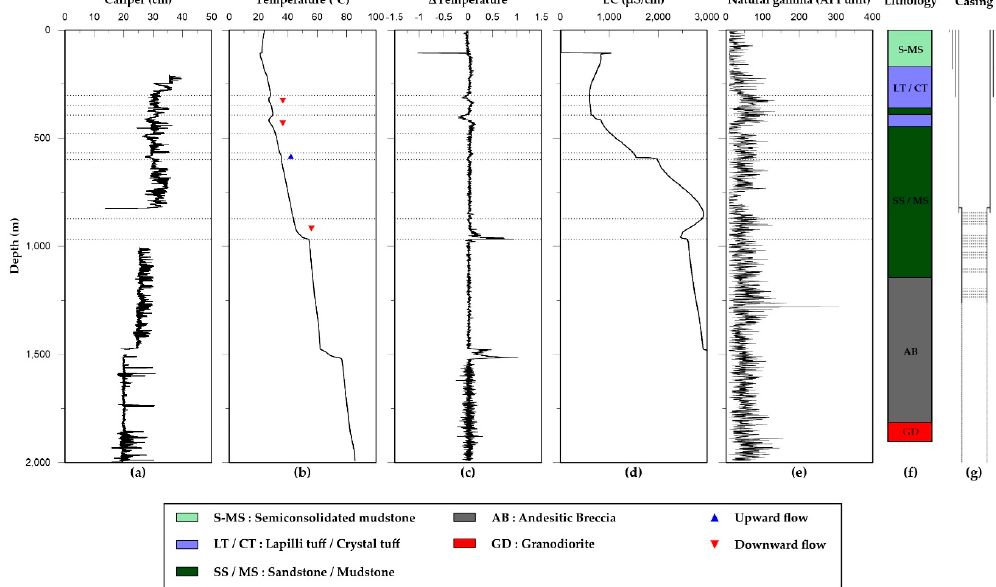
Figure 8. Geophysical and lithological profiles of BH-4: ( a ) Caliper log; ( b ) temperature log; ( c ) delta temperature log; ( d ) electrical conductivity (EC) log; ( e ) natural gamma-ray logs; ( f ) a simplified lithological log; and ( g ) a casing installation. The blue triangle indicates upward ground flow and the red upside-down triangle indicates downward ground flow. Estimated depth intervals where the groundwater flows occurred are marked with dotted lines.